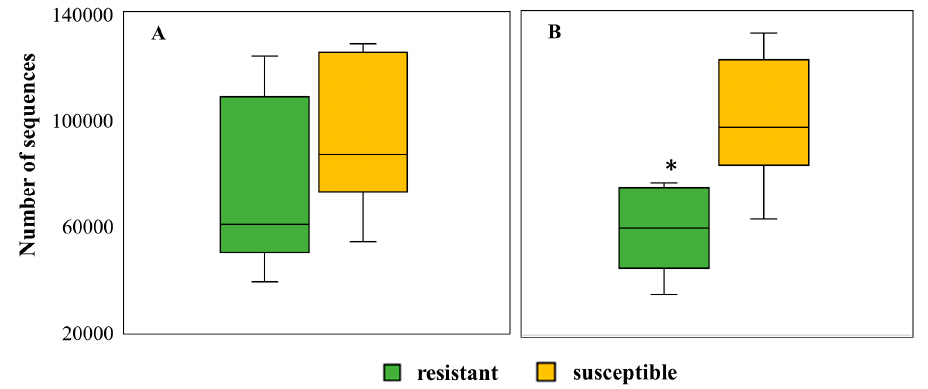
Figure 7. Comparison of the sequence reads mapped to the reference genome of Zymoseptoria tritici between the resistant and susceptible genotypes. A comparison was made between ( A ) all resistant lines / parent and susceptible lines / parent at 10 dpi, ( B ) all resistant lines / parent and susceptible lines / parent at 12 dpi, (2 sample t-test, * p < 0.01).